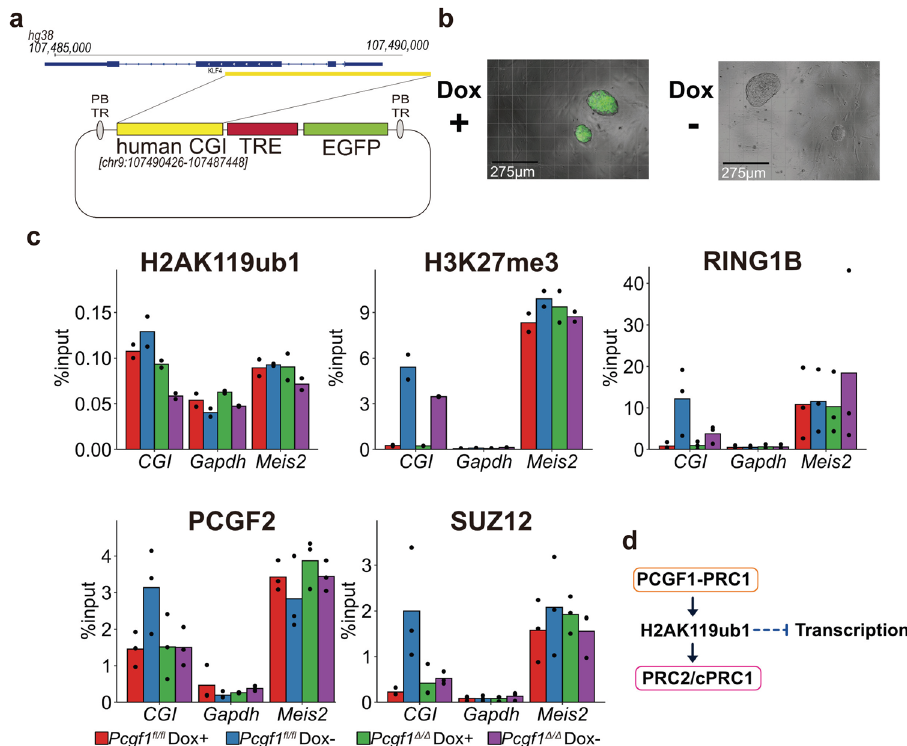
Fig. 5 Transcriptional downregulation at cis -regulatory elements facilitates PRC2 recruitment to a CGI in a PCGF1-dependent manner. a Schematic representation of the drug-inducible reporter construct. The vector contains a human KLF4 CpG island (human CGI), a Dox-inducible promoter (TRE), and an EGFP gene. This reporter vector was stably integrated into Pcgf1 -KO ESCs by piggyBAC transposase. b Dox-dependent expression of EGFP from the reporter construct in ESCs. Representative micrographs were shown. Experiments were repeated independently at least 2 times with the same results. c Dox- and PCGF1-dependent regulation of the accumulation of H2AK119ub1, H3K27me3, RING1B, SUZ12, and PCGF2 at the CGI of the reporter gene in ESCs. Bar graphs for ChIP-qPCR results for H2AK119ub1, H3K27me3, RING1B, SUZ12, and PCGF2 at the human CGI of the reporter, Gapdh and Meis2 in WT ( Pcgf1 fl / fl ) or Pcgf1 -KO ( Pcgf1 Δ / Δ ) ESCs in the absence or presence of Dox (-Dox and + Dox, respectively) are shown. Data are represented as mean ± SEM ( n = 3). d Schematic summary for the role of PCGF1-PRC1 to link H2AK119ub1 with PRC2 revealed in this study. PCGF1-PRC1 mediates H2AK119ub1 deposition and contributes to the consolidation of gene silencing via unde fi ned mechanisms (indicated by dotted line) and in turn recruitment of PRC2 and cPRC1 (indicated by an arrow). H2AK119ub1-dependent recruitment of PRC2 and canonical PRC1 is inhibited by transcriptional activity (indicated by a solid